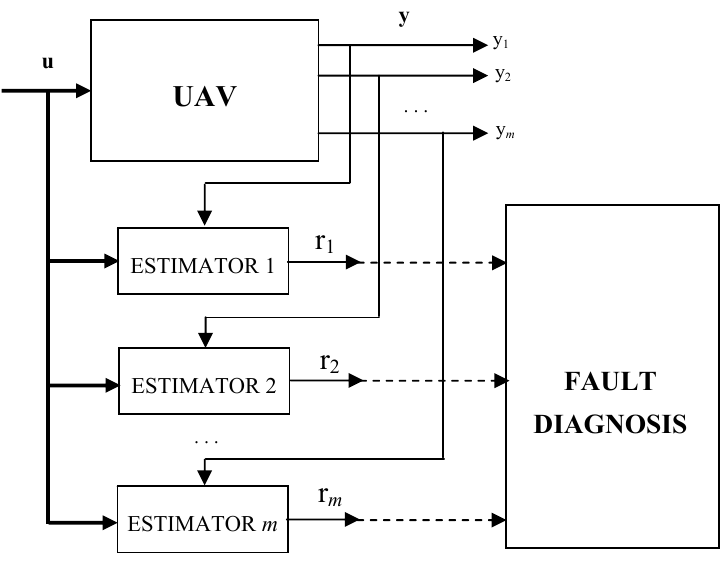
Figure 1. Bank of estimators for output residual